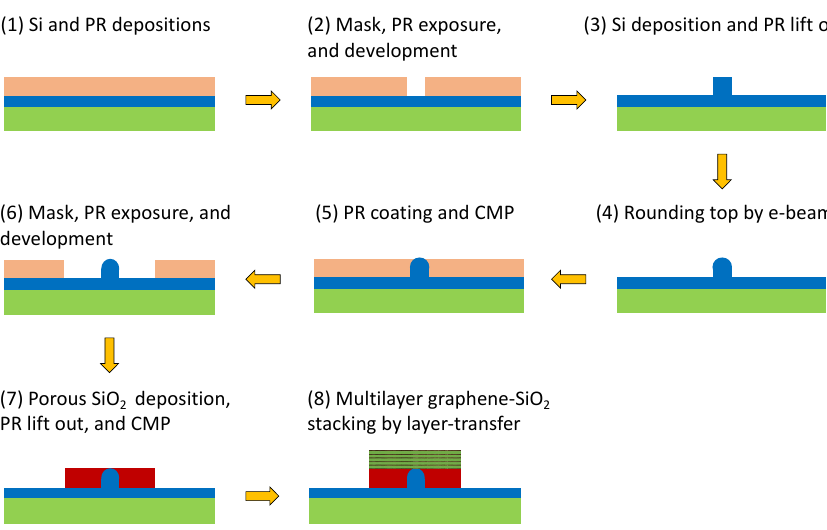
Figure 2. Schematic of the fabrication process for the proposed waveguide structure.